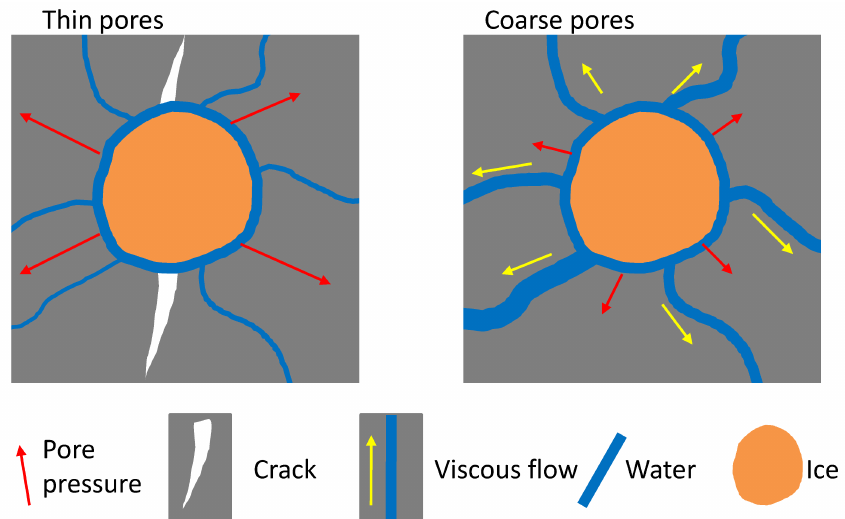
Figure 10. Schematic illustration of the freezing resistance differences between a material with thin pores and that with coarse